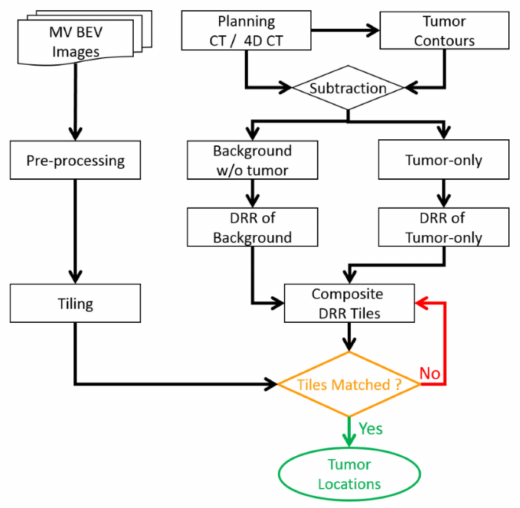
Figure 2. Flow chart of the markerless lung tumor detecting